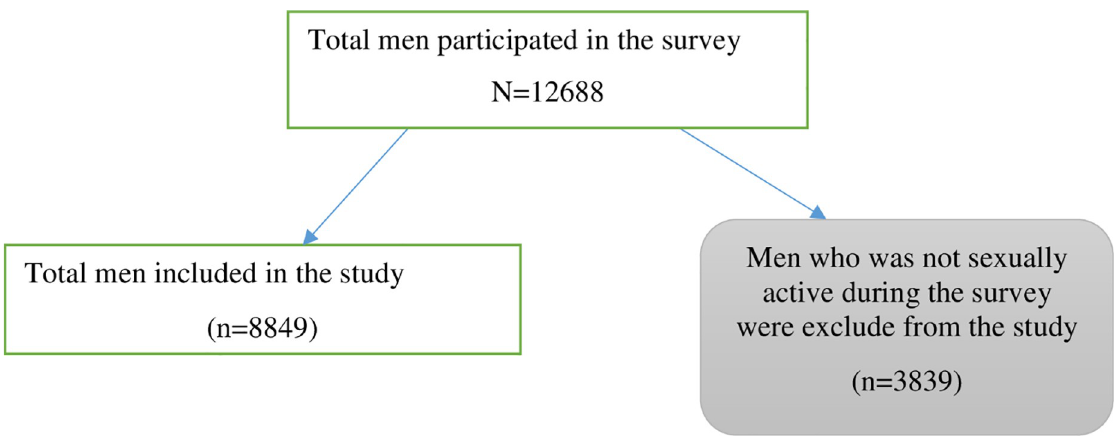
Fig 1. Schematic presentation to select participants to identify factors associated with STI among men Ethiopia; 2016 EDHS.